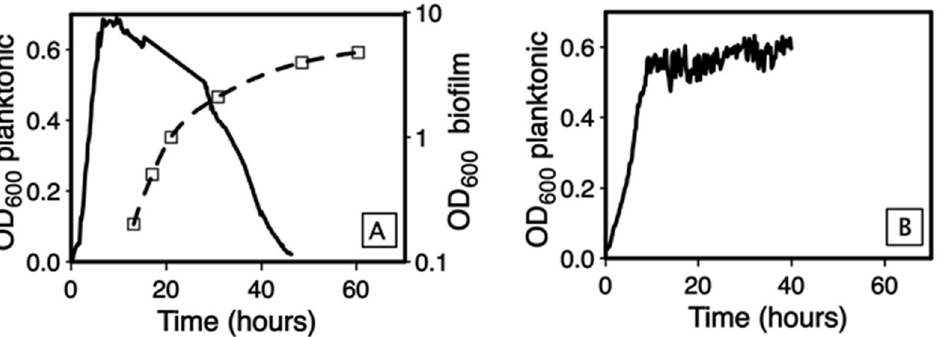
Figure 2. Time-course of the OD 600 for planktonic or sessile populations in glass tube assay. ( A ): Strain Bt407 ; ( B ): Bt407 ∆ Spo0A. Plain line: planktonic population; dotted line: sessile population. Left y -axis: planktonic population OD 600 , linear scale; Right y -axis: biofilm OD 600 , log-scale.